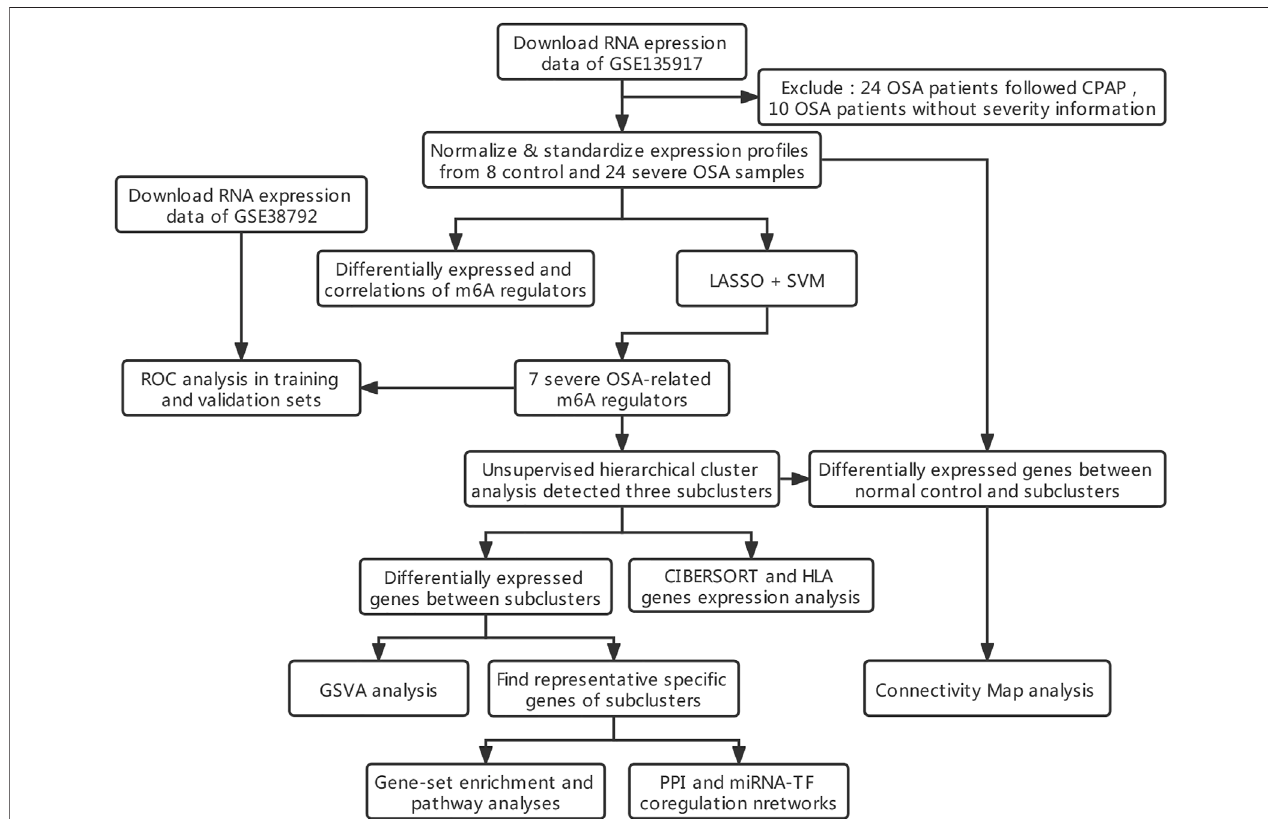
FIGURE1| Work fl owandanalysisstrategyusedinthecurrentstudy.Abbreviations:LASSO,leastabsoluteshrinkageandselectionoperator.SVM,supportvector machine.ROC,receiveroperating characteristiccurve.GSVA,genesetvariationanalysis.GO,GeneOntology.KEGG, Kyotoencyclopediaofgenesandgenomes.PPI, protein-protein interaction networks. TF: transcription